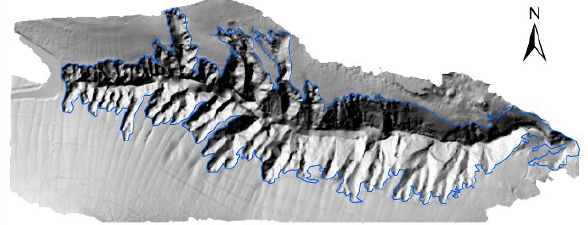
Figure 7. Shoulder line of whole